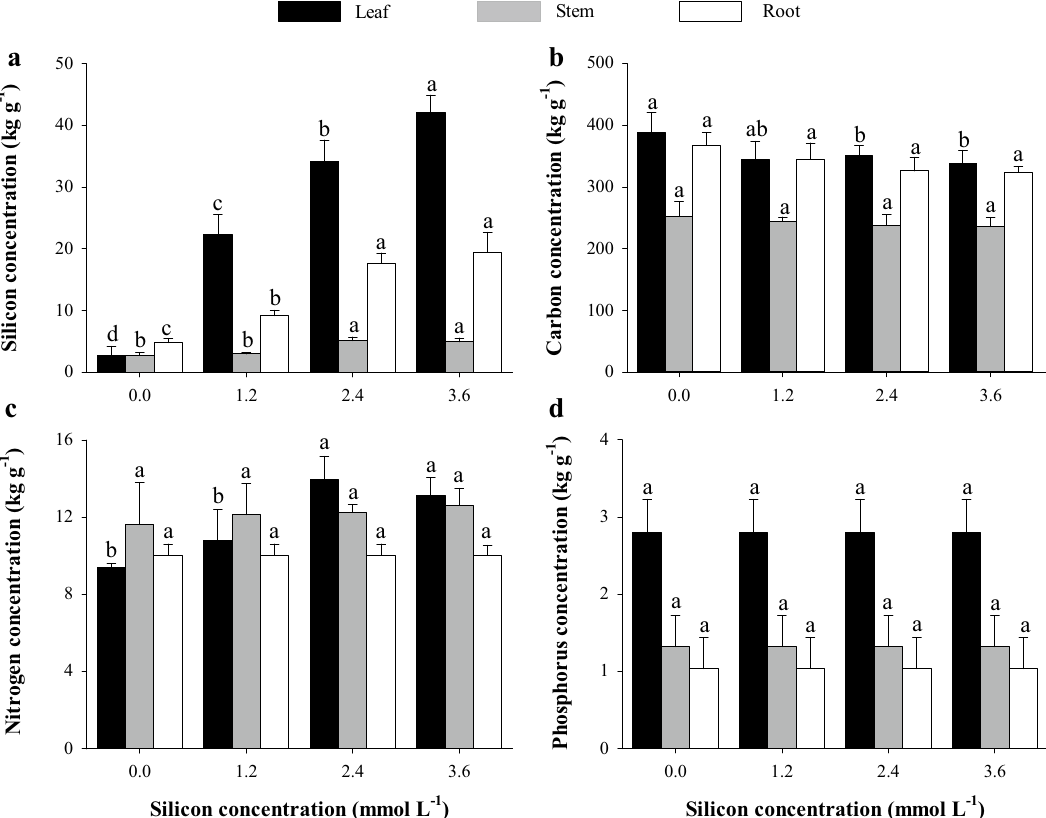
Figure 1. Concentration of silicon (Si) ( a ), carbon (C) ( b ), nitrogen (N) ( c ), and phosphorus (P) ( d ) in different parts of grain sorghum plants under different Si concentrations. Error bars over the dots indicate the standard error of the mean, *, **, and ns—significant at 1%, at 5%, and not significant by the F test,